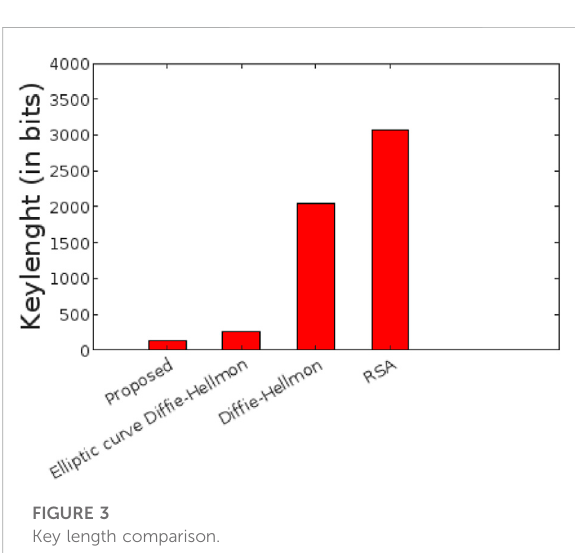
FIGURE 3 Key length